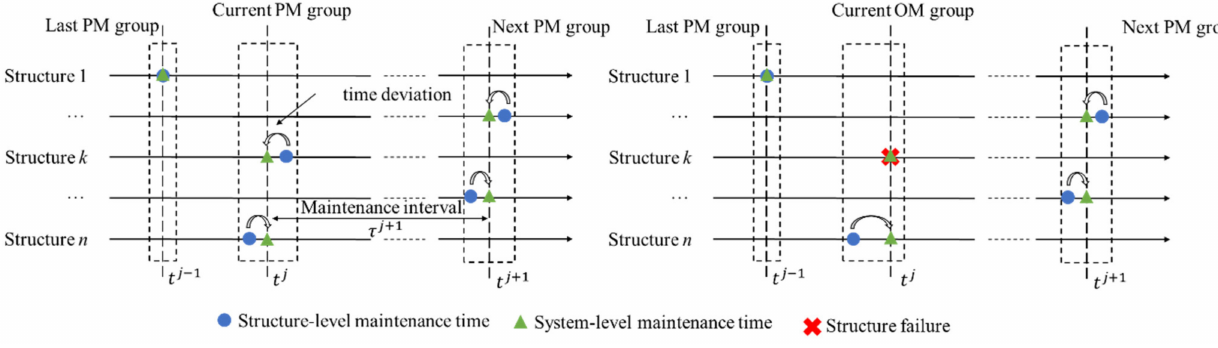
Figure 1. Illustrations of preventive grouping ( left ) and opportunistic grouping ( right